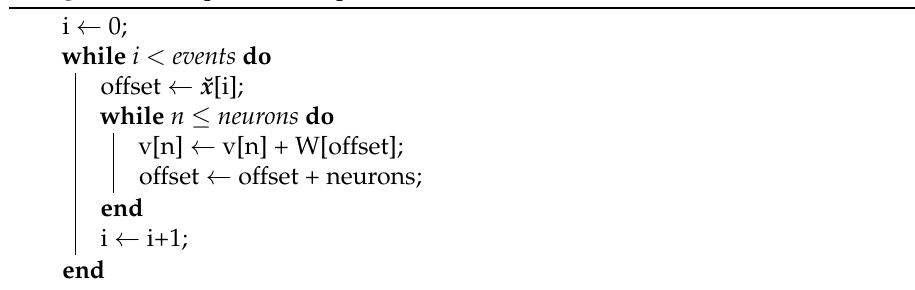
Algorithm 2: Optimized implementation of v ← W x when x is a boolean